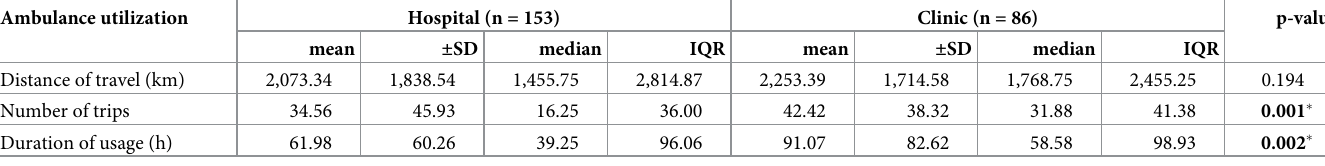
Table 3. Utilization of ambulance services (n =